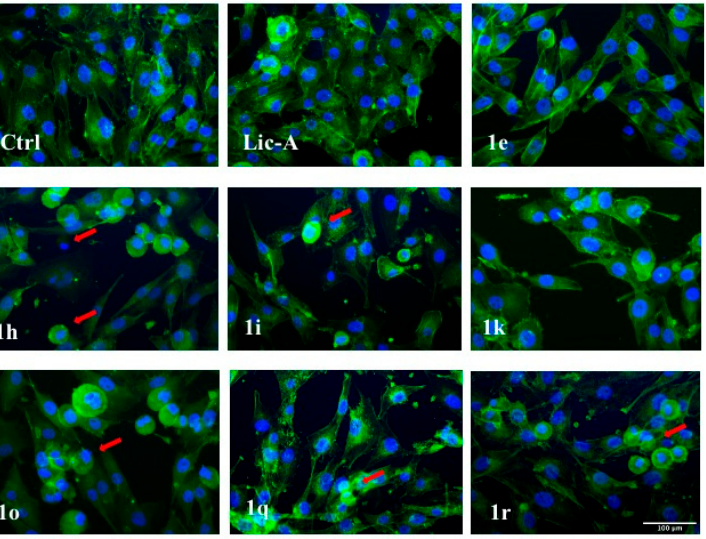
Figure 7. Effects of chalcones on MG63 morphology. Fluorescence microscopy of control and cells treated at IC 50 concentrations for 24 h. Nuclei and F-actin are stained with Hoechst (blue) and phalloidin (green) respectively. The arrows indicated the destructured F-actin fibers. Scale bar 100 µm.